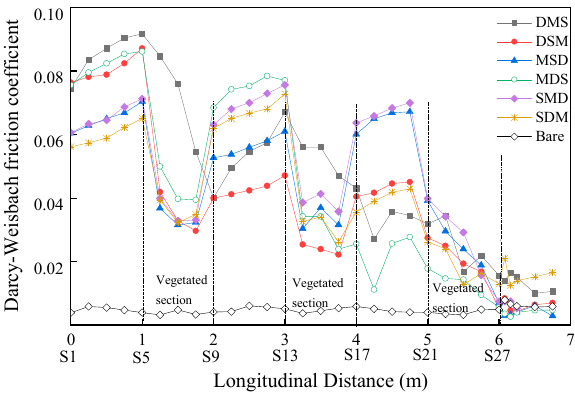
Figure 8. Variation of the Darcy–Weisbach friction coefficients in the longitudinal direction.